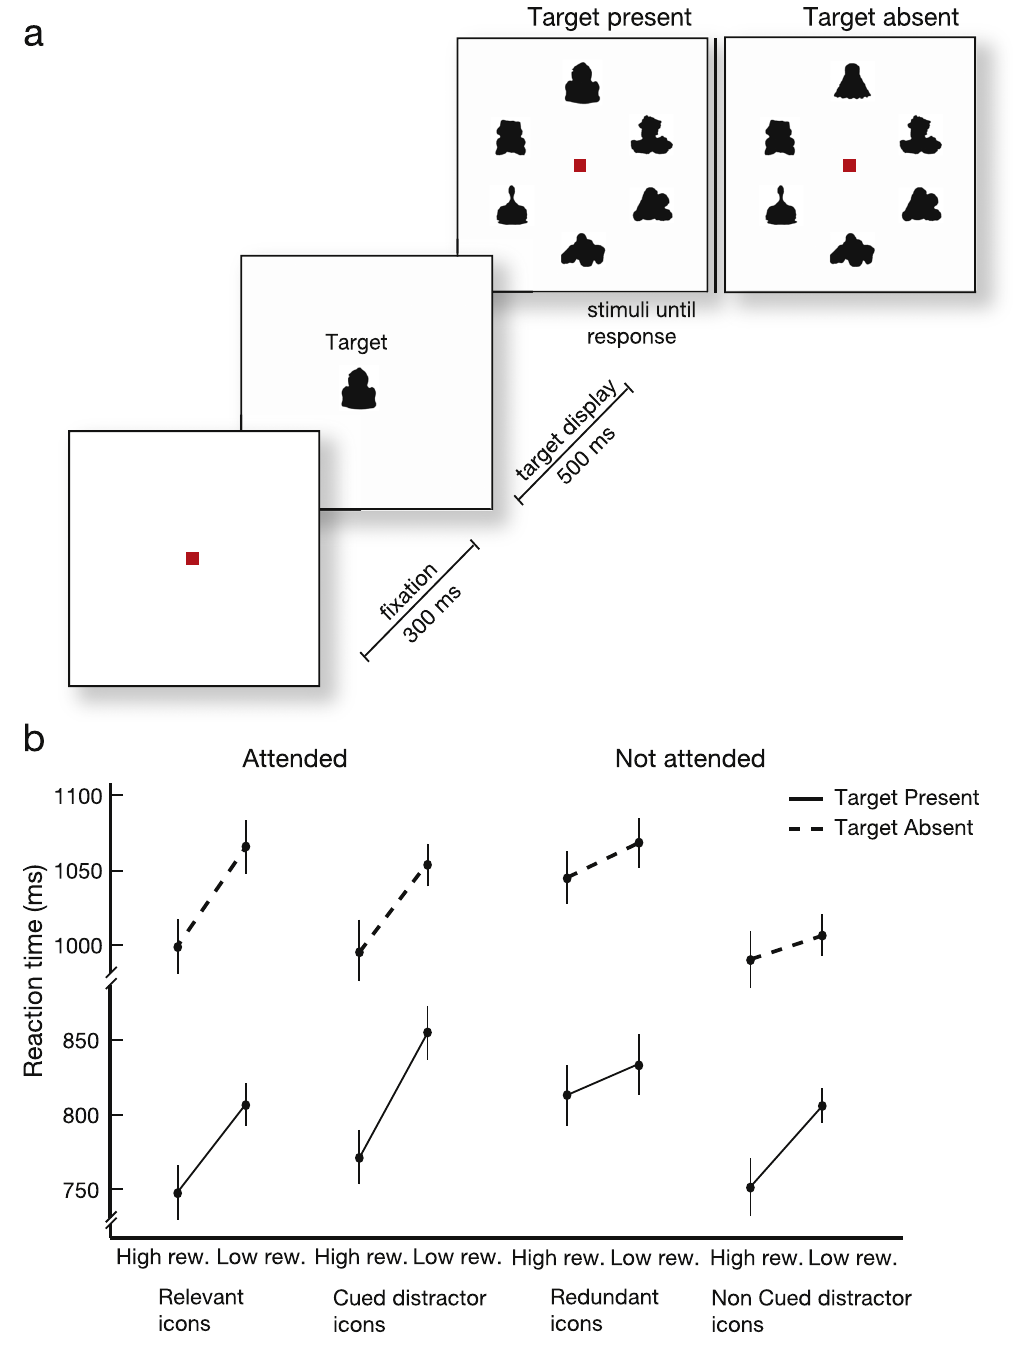
Figure 3. Visual search task. ( a ) Trial structure. Participants indicated the presence of a target icon. ( b ) Mean reaction time on trials in which subjects searched for the previously displayed icons with different reward values. Continuous (dashed) lines, reaction times in target-present (target absent) trials. All error-bars are s.e.m. across